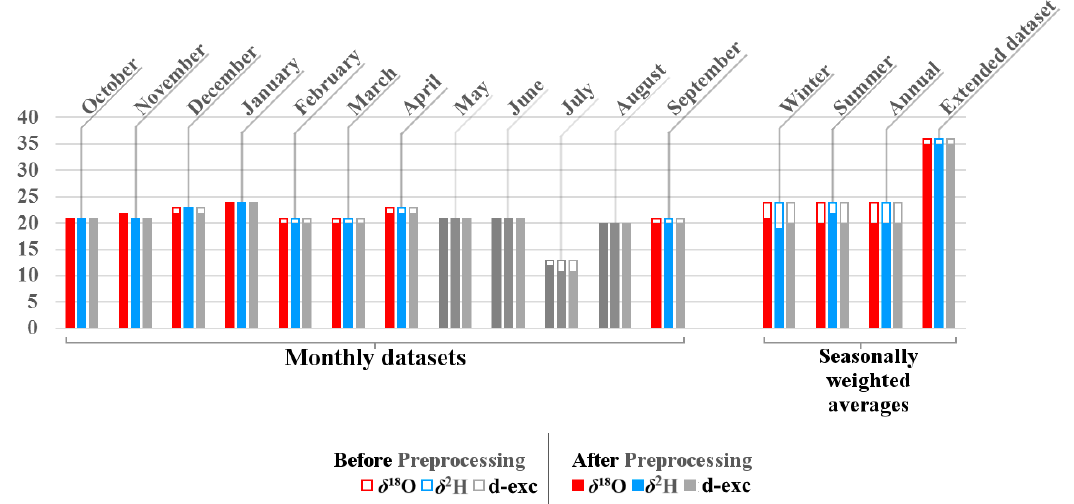
Figure 3. The number of precipitation stable isotope records in the initial monthly and multi-monthly datasets before and after preprocessing entered into the semivariogram analysis. Winter: October–March; summer: April–September. Grey bars represent the months omitted from the analysis, see text for details. The open part of a column indicates that some values were discarded after the quality check of the raw data (see Section 2.3.2).